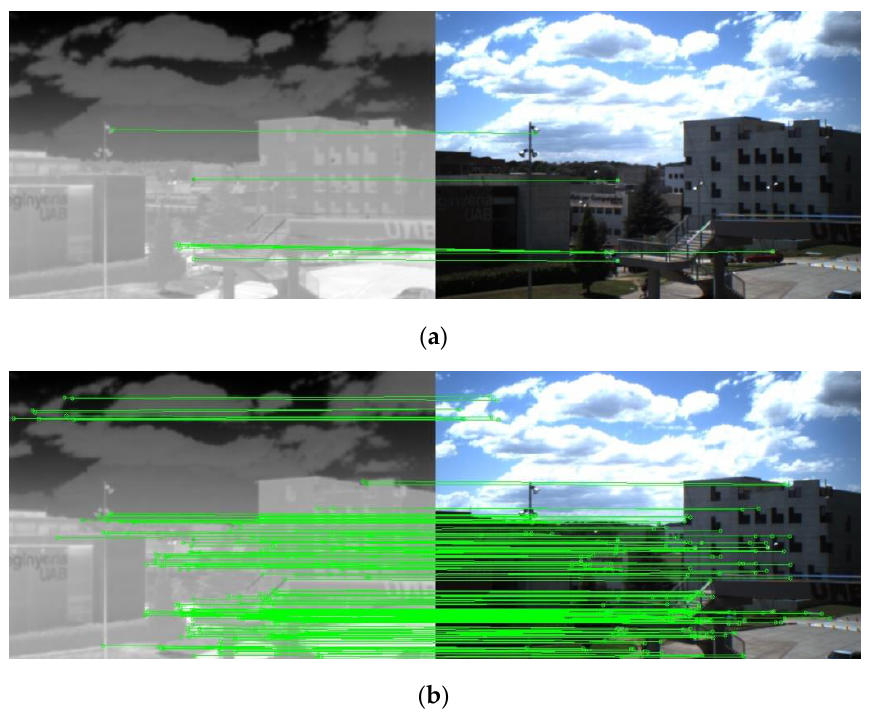
Figure 6. Feature match after RANSAC. ( a ) Matching Results of LGHD. ( b ) Matching Results of DDCE.